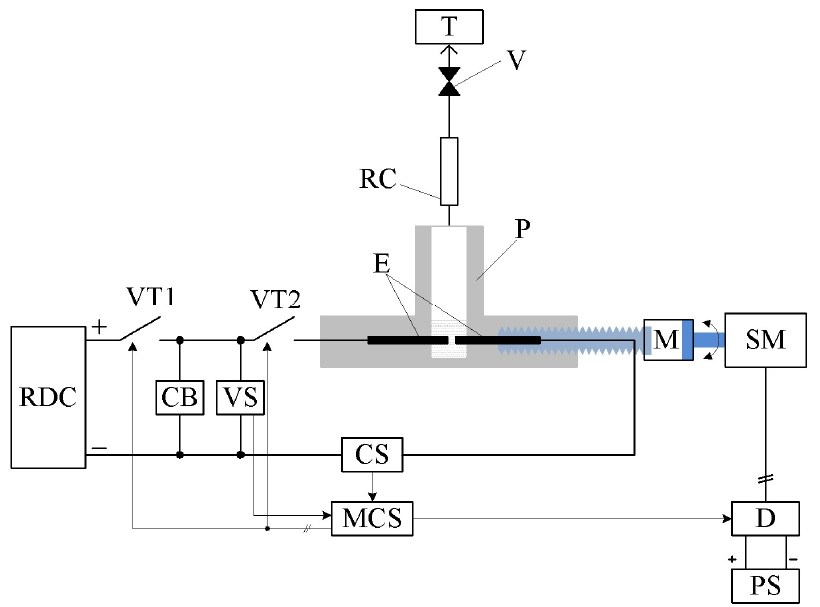
Figure 1. Block diagram of the laboratory setup.